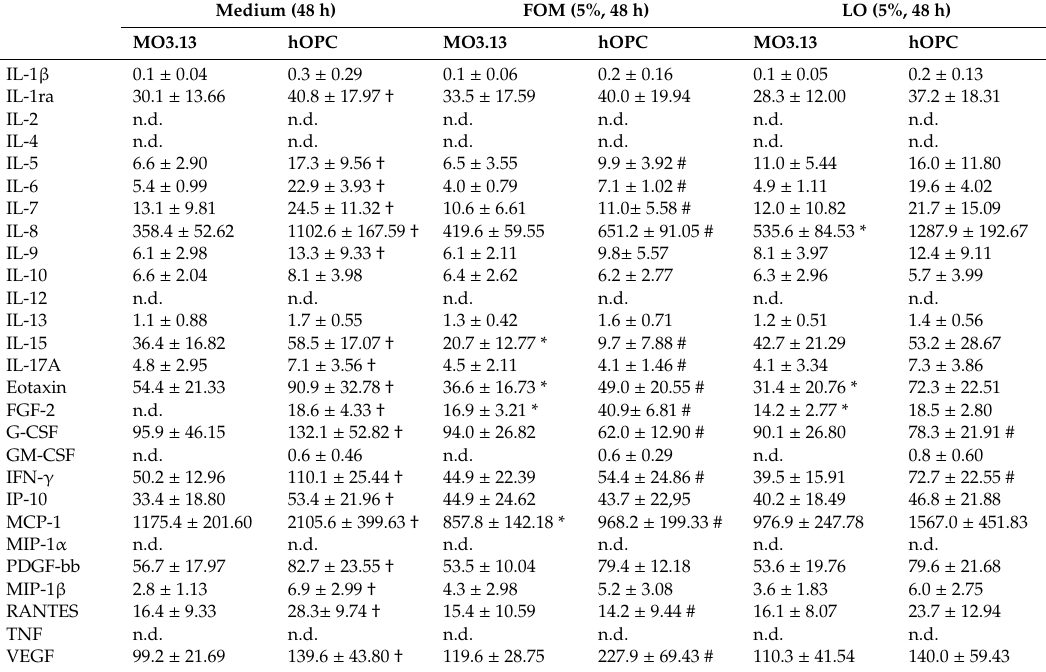
Table 3. The profile of cytokines, chemokines, and growth factors released by MO.3.13 cells and hOPCs supplemented with FOM or LO. Data are presented in pg / mL as means ± SD from four independent